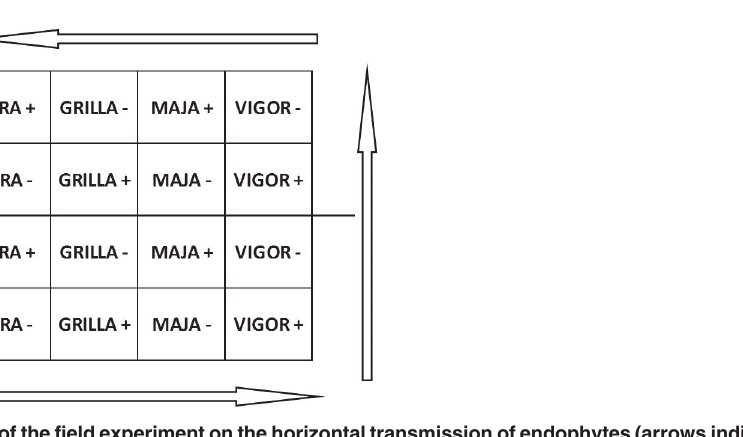
Fig 1. Layout of the field experiment on the horizontal transmission of endophytes (arrows indicate the mowing directions).